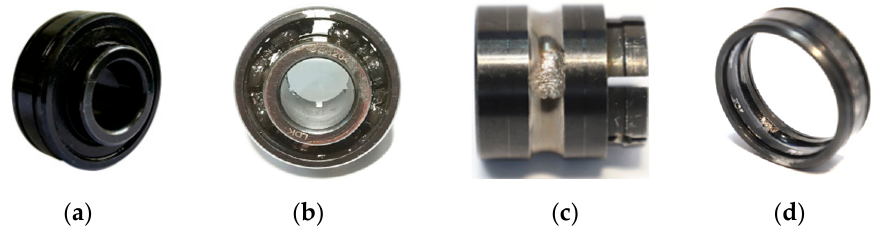
Figure 6. Bearing fault. ( a ) normal, ( b ) cage fracture, ( c ) inner race wear, ( d ) outer race wear. Table 1. Experimental datasets of CWRU.